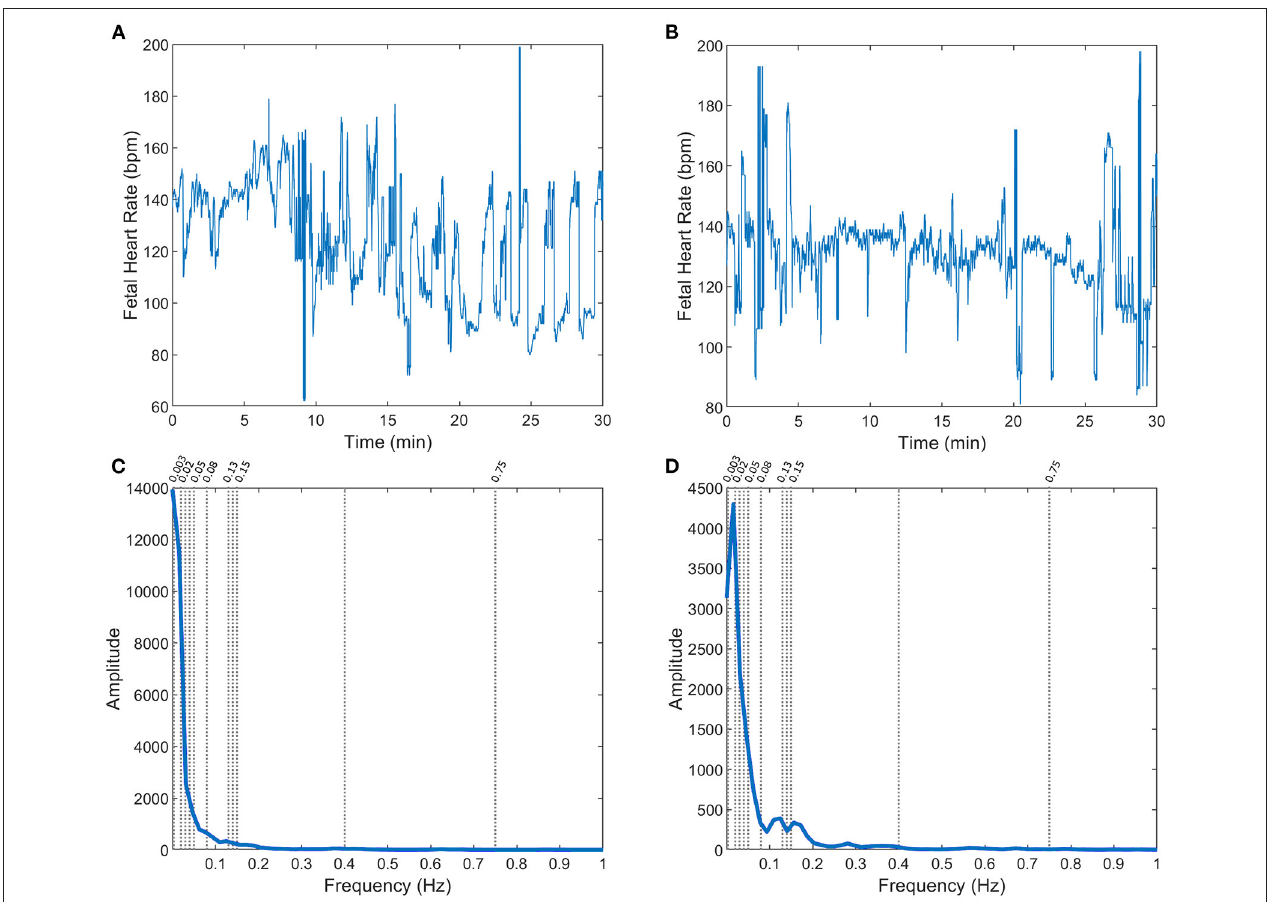
FIGURE 2 | FHR (A,B) and respective power spectra ( C,D , with specific frequency limits) for two fetuses in the CTG database: with arterial blood pH = 7.02 (A,C) and pH = 7.2 (B,D) , at